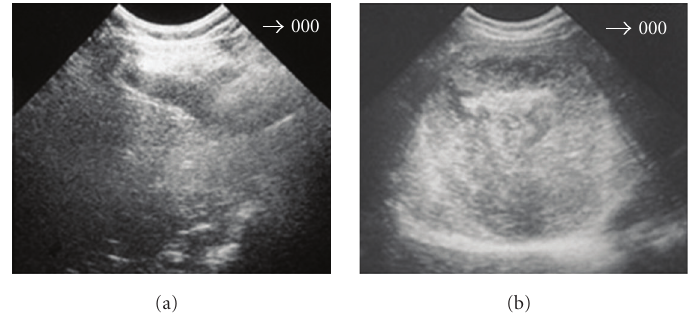
Figure 6: Hydatid cyst of the liver after treatment: (a) Cyst vanishing; (b) Cyst vestiges.